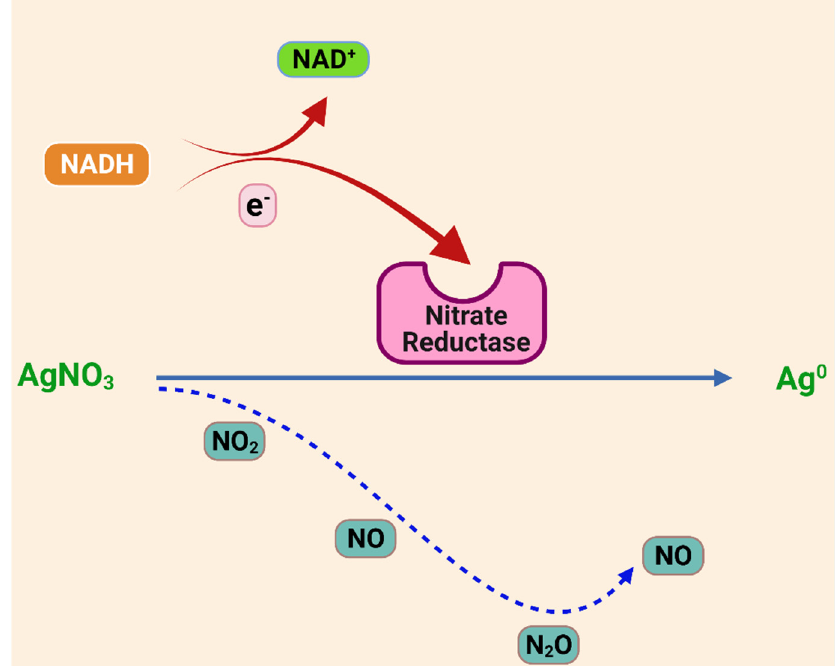
Figure 5. Nitrate reductase-mediated biogenic synthesis of AgNPs.